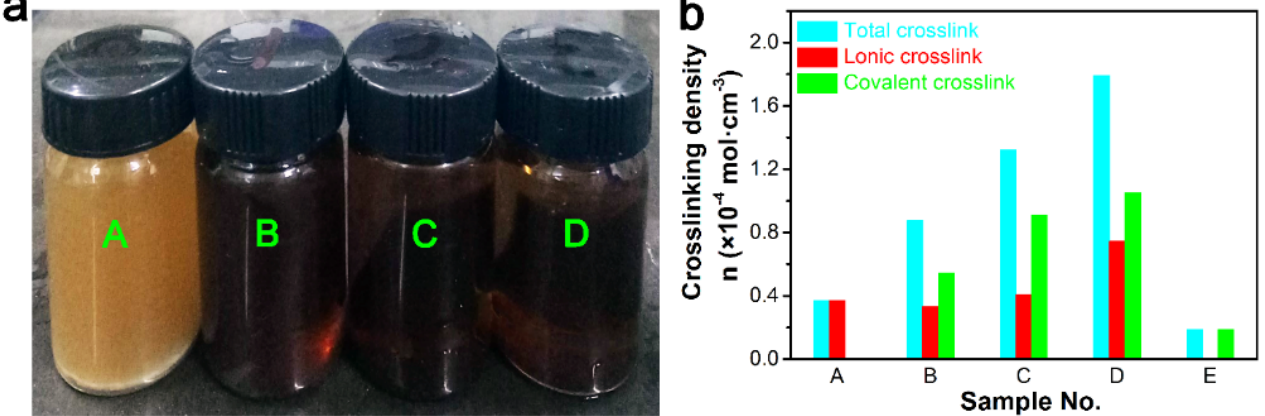
Figure 5. ( a ) Digital photographs of composites with different DCP content after dissolution/swell experiment, and ( b ) cross-link density of ER composites with different DCP content.